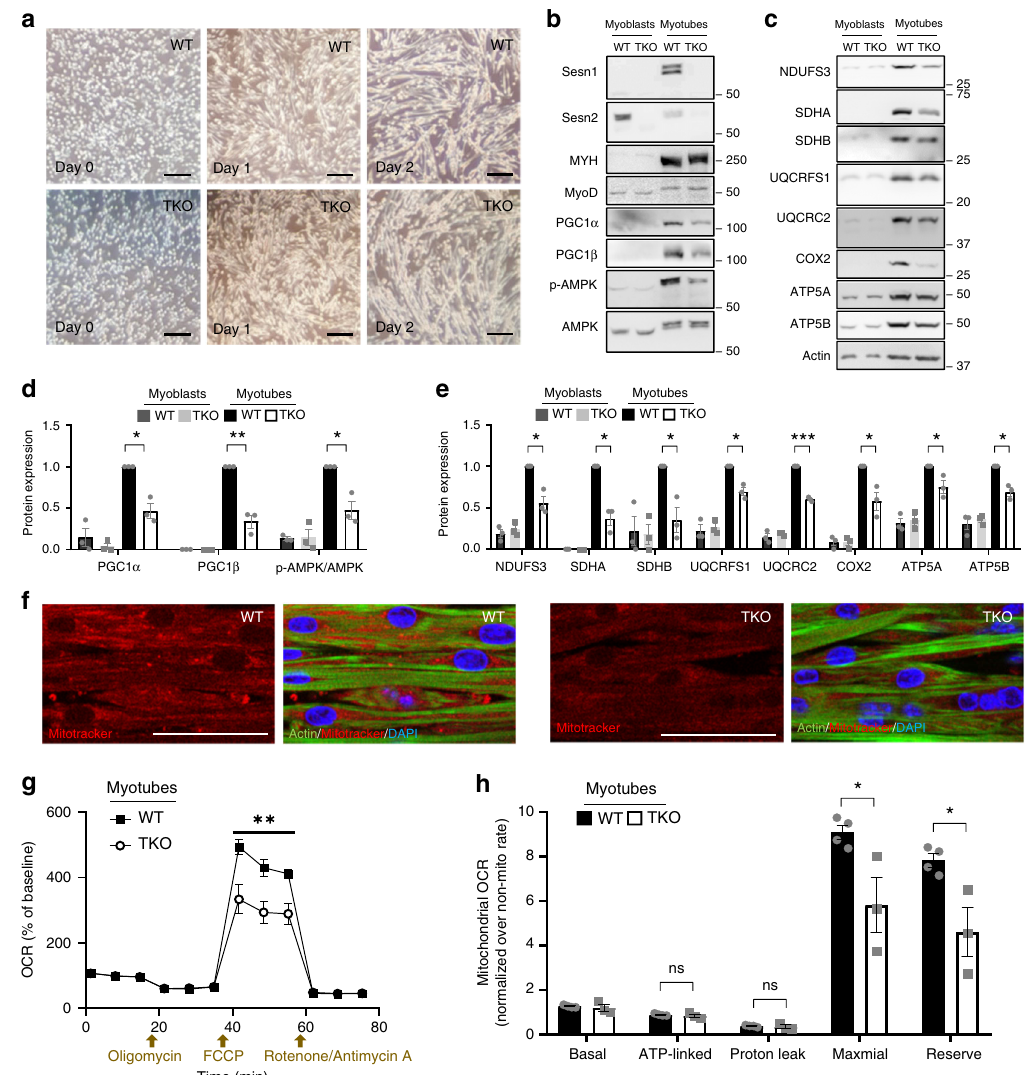
Fig. 6 Sestrin is required for maximal oxidative capacity of muscle mitochondria. a Myoblasts isolated from WT and TKO mice were differentiated into myotubes. Light microscopy examination of myotube cultures after indicated days of differentiation. Scale bar, 200 µ m. b – e Immunoblotting ( b , c ) and densitometry ( d , e ; values relative to WT myotube levels) of indicated proteins in WT and TKO myoblasts before (left) and after (right) myotube differentiation. ( f ) Phalloidin (green), mitotracker (red) and DAPI (blue) staining of WT and TKO myotubes. Scale bar, 50 µ m. g Oxygen consumption rate (OCR) of WT and TKO myotubes, normalized by corresponding baseline OCR, after treatment with oligomycin, carbonyl cyanide-4-phenylhydrazone (FCCP) and rotenone/antimycin A. h Indicated mitochondrial OCR was calculated from ( g ), normalized by non-mitochondrial OCR. Biologically independent replicates: n = 3 ( d , e ), n = 4, 3 ( g , h ; WT and TKO, respectively). Error bars, s.e.m. * P < 0.05, ** P < 0.01, *** P < 0.001 or ns, non-signi fi cant from a two-tailed student ’ s t test. Molecular weight markers are indicated in